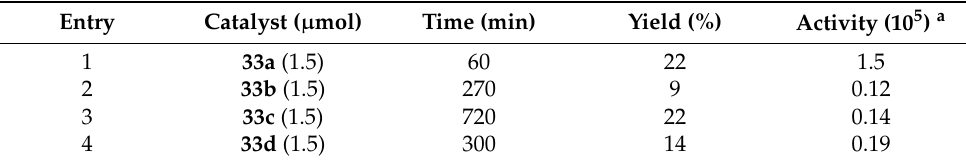
Table 5. Comparison of the catalytic performances of the unsymmetrical NNP nickel pincer com- plexes 33a – 33d for the catalytic polymerization of norbornene